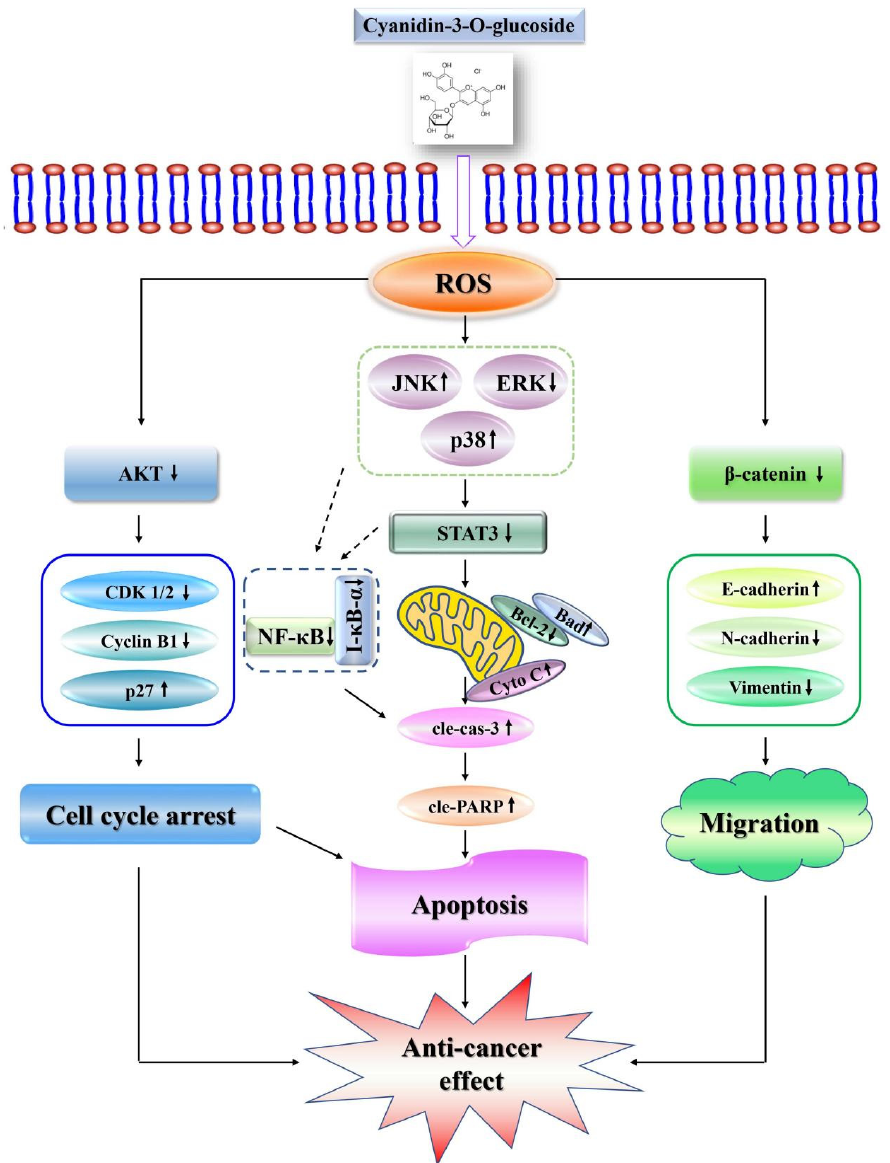
Figure 8. Anticancer mechanism of C3G in human GC MKN-45 cells. C3G induced apoptosis through ROS-mediated MAPK, STAT3, and NF- κ B signaling pathways; arrested cells in the G2/M phase through the AKT signaling pathway; and inhibited cell migration through the β -catenin signaling pathway in human GC MKN-45 cells. Dashed arrows indicate possible regulatory relationships, and dashed boxes indicate the proteins that make up the family. The solid arrows show the relationships confirmed in this study, and the solid boxes show the proteins related to the regulation of the cell cycle and cell